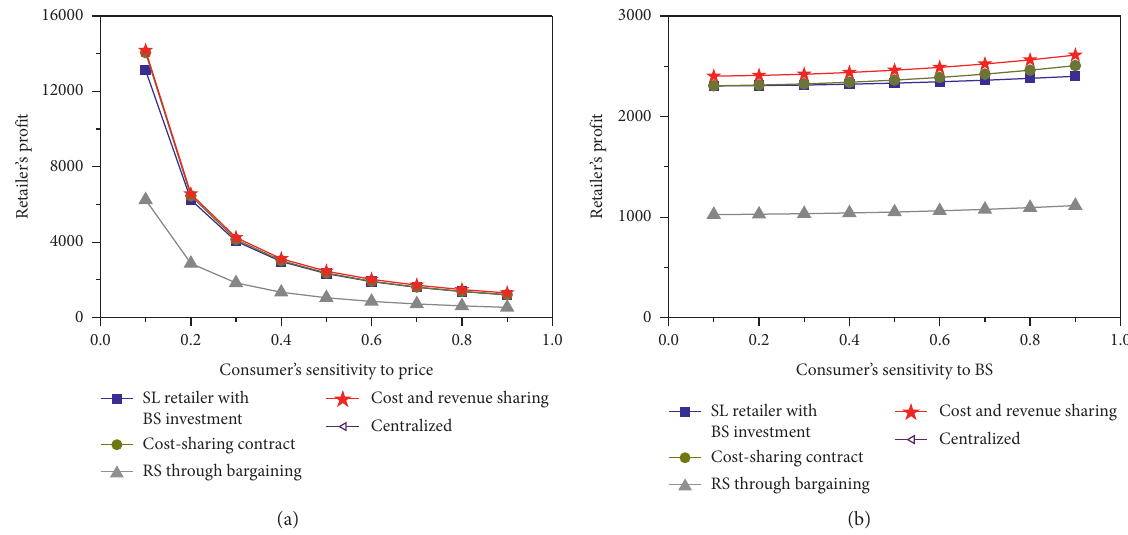
Figure 1: (a) The effect of optimal b on the expected profits of the retailers. (b) The effect of optimal β on the expected profits of the retailers.